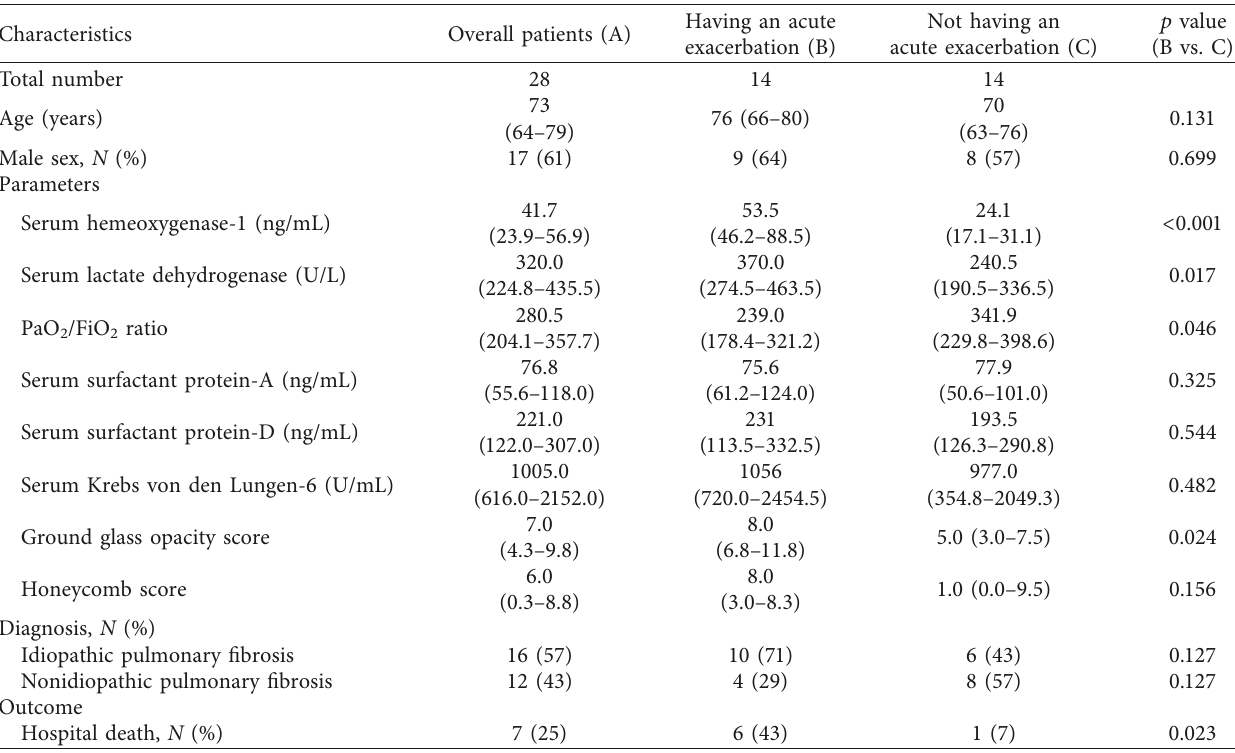
Table 1: Patients’ characteristics.